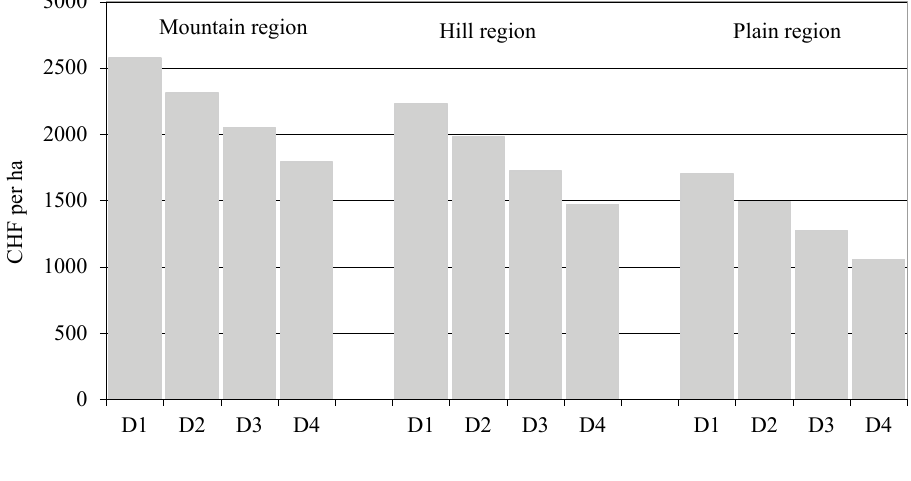
Figure 3. SAP per hectare (including ecological direct payments and cultural-landscape